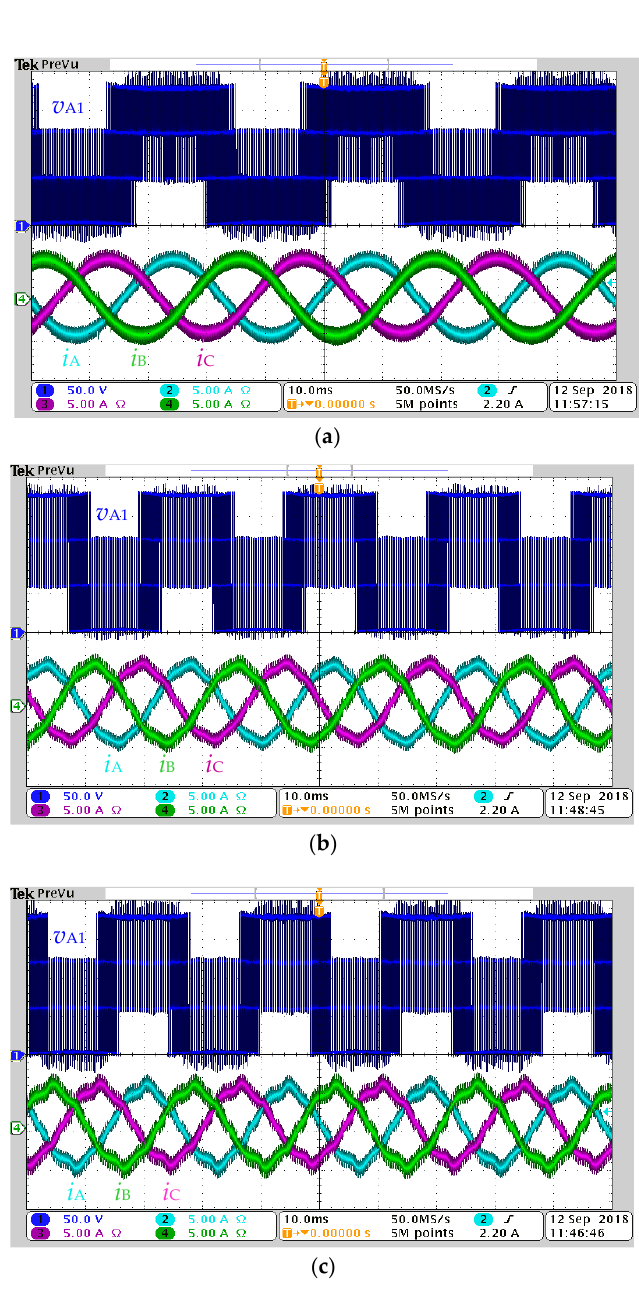
Figure 9. Experimental results of phase currents i A , i B , and i C , and phase voltage v 1A , operating in UM and OM regions. ( a ) Operation in UM: ω * = 450 rpm, load torque = 10 Nm, m * = 0.76; ( b ) Operation in OMI: ω * = 610 rpm, load torque = 10 Nm, m * = 1.01; ( c ) Operation in OMII: ω * = 620 rpm, load torque = 10 Nm, m * = 1.03 (remaining conditions are the same as in Figure 7 for ( a ), ( b ) and ( c )).